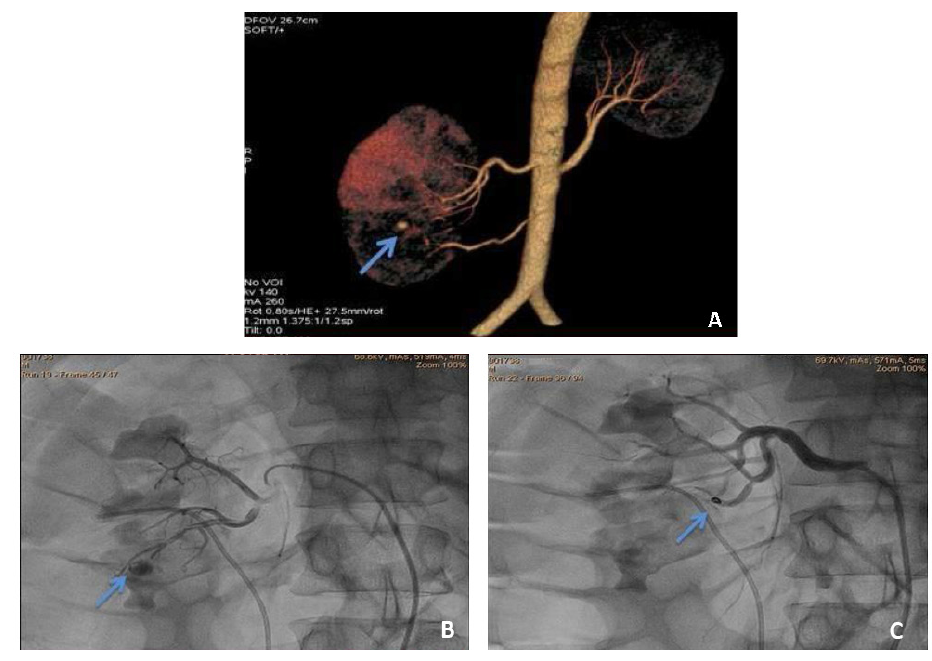
Figure 4. Case 8. a ) The MDCT angiogram shows the presence of two renal arteries. In addition it also shows aneurysmal dilatation of lower pole segmental branch of right upper renal artery (arrow). b and c ) A conventional angiogram done the catheter is manipulated into the appropriate branch and embolisation done